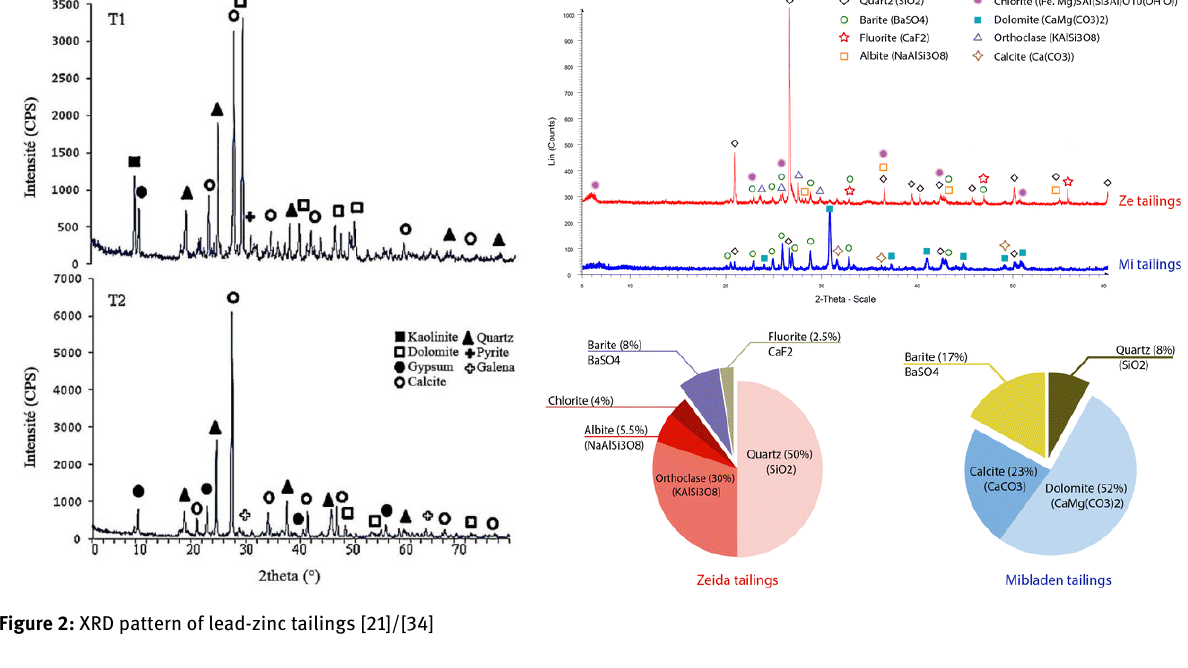
Figure 2: XRD pattern of lead-zinc tailings [21]/[34]